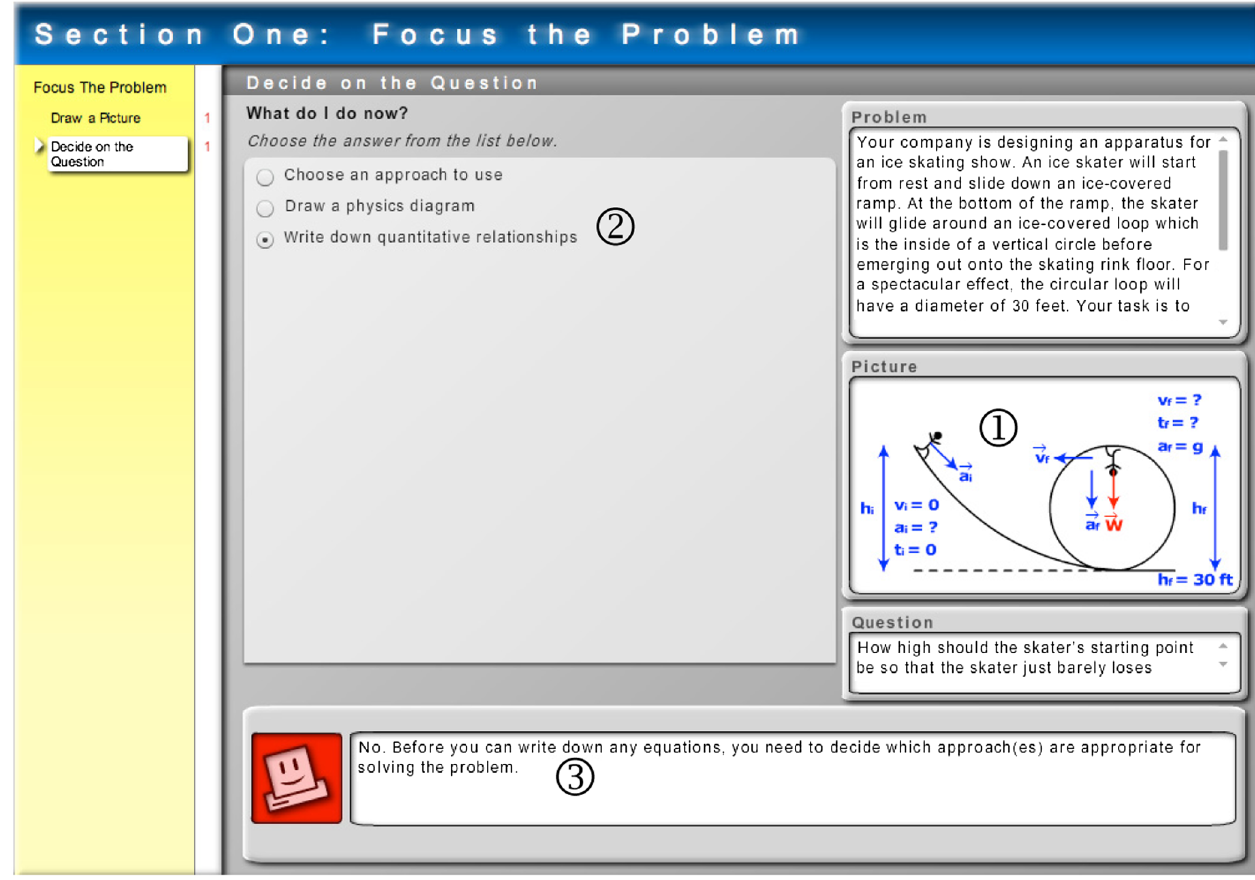
FIG. 2. Screenshot from a type 2 coach (student coaches computer). The display shows a completed picture ① . The student, acting as a coach, has decided on a step for the computer, in its role as a student, to perform ② , but it is not an appropriate step at this point. The computer, in its oversight role, gives the student feedback ③